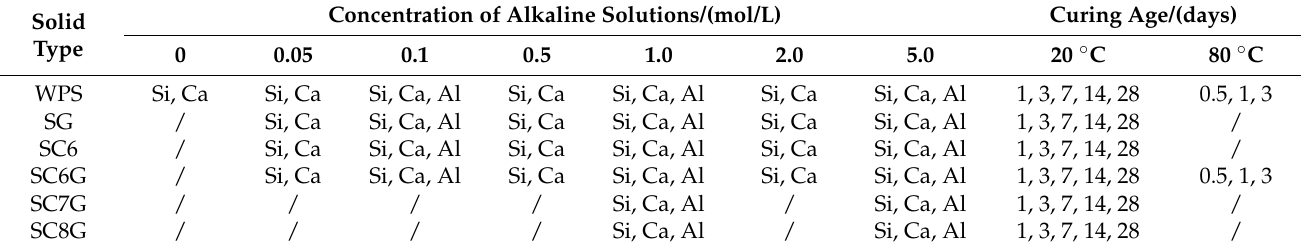
Table 2. Parameter of the leaching